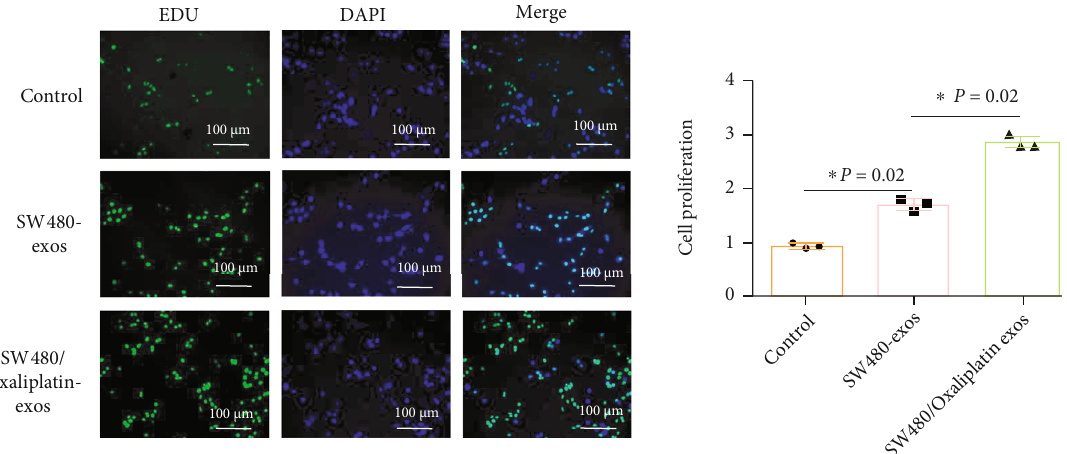
Figure 3: SW480/oxaliplatin cell-derived exosomes promotes cell proliferation. Exosomes were extracted from SW480/oxaliplatin and SW480 cells and then co-cultured with HUVECs. E ff ects of SW480/oxaliplatin cell-derived exosomes on proliferation of HUVECs were detected by EdU. All the above experiments were repeatedly performed 3 times; data are shown as the means ± SD . ∗ P < 0 : 05 , ∗∗ P < 0 : 01